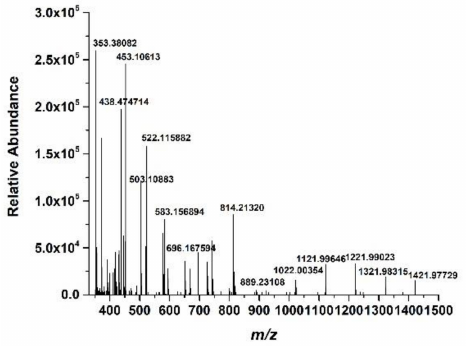
Figure 6. The mass spectrum of the prepared Cornus officinalis peptides.